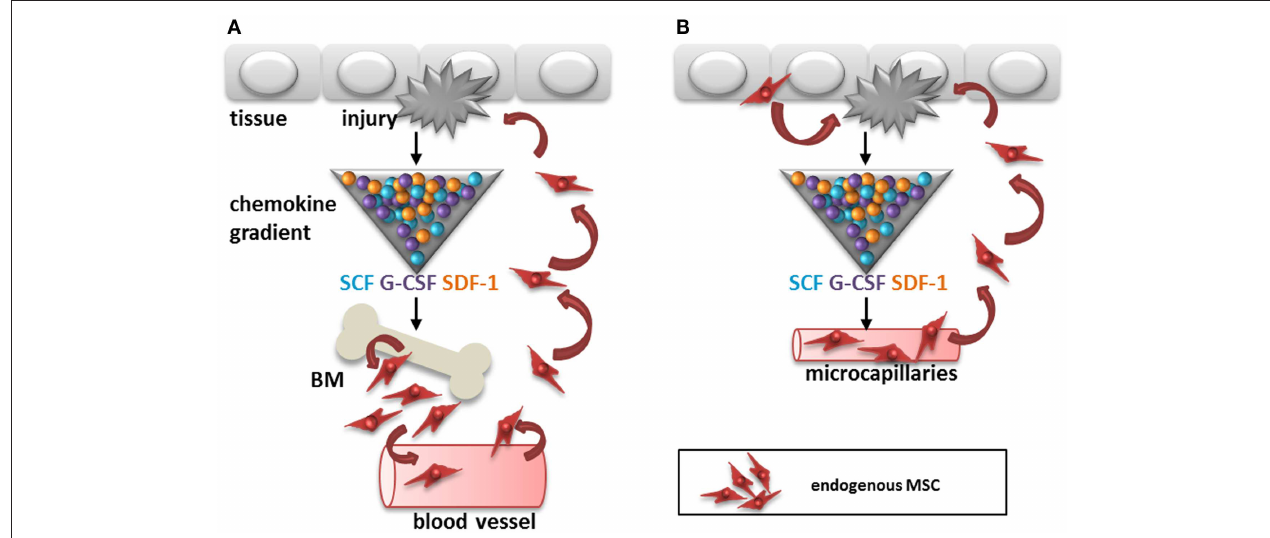
FIgure 1 | two potential routes for recruitment of endogenous MSc after tissue injury. (A) Cytokines, chemokines, and growth factors like SCF, G-CSF, and SDF-1 are released by the injured tissue, which may trigger recruitment of MSC from the bone marrow to sites of injury via the circulation.